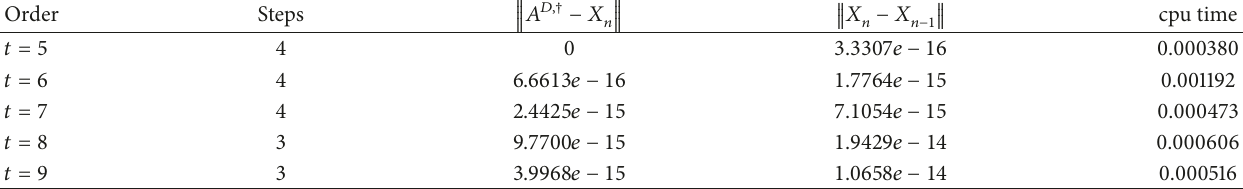
Table 1: Numerical results of Scheme I with 𝛼 = 0.2 in Example